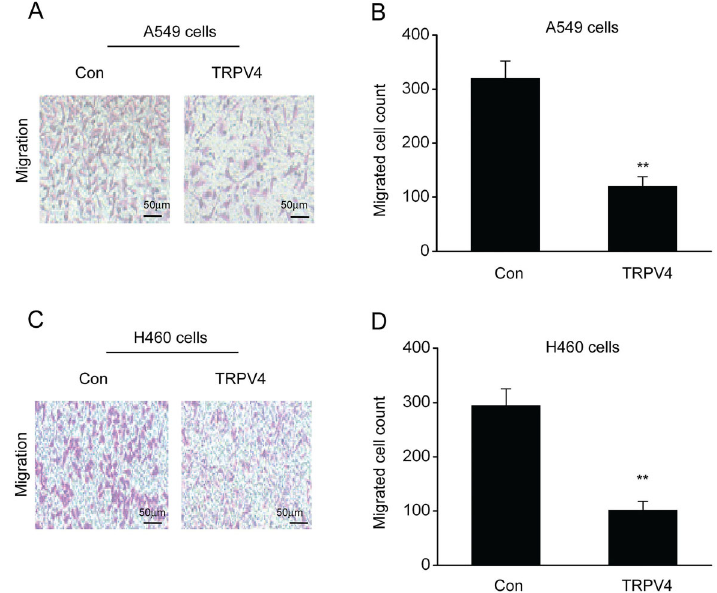
Figure 3. Overexpression of TRPV4 suppressed migration of lung cancer (LC) cell lines. A , C , Images showing migrated A549 ( A ) and H460 ( C ) cells on the bottom surface of transwell membranes in A549 cells transfected with the control plasmid pcDNA3.1( + ) (Con) and plasmid pcDNA3( + )/TRPV4 (TRPV4) (scale bar 50 m m). Quantity of migrated A549 ( B ) and H460 ( D ) cells in 5 random microscopy fi elds in different groups. Data are reported as means ± SE. **P o 0.01 ( t -test).